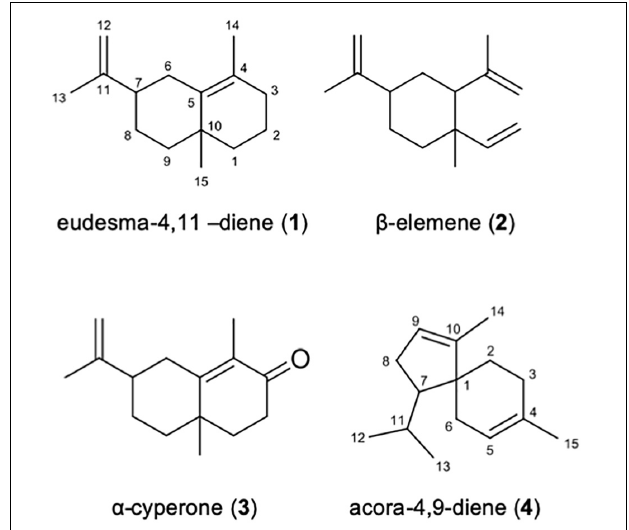
FIGURE 6 | Identified sesquiterpenes present in P. nodorum